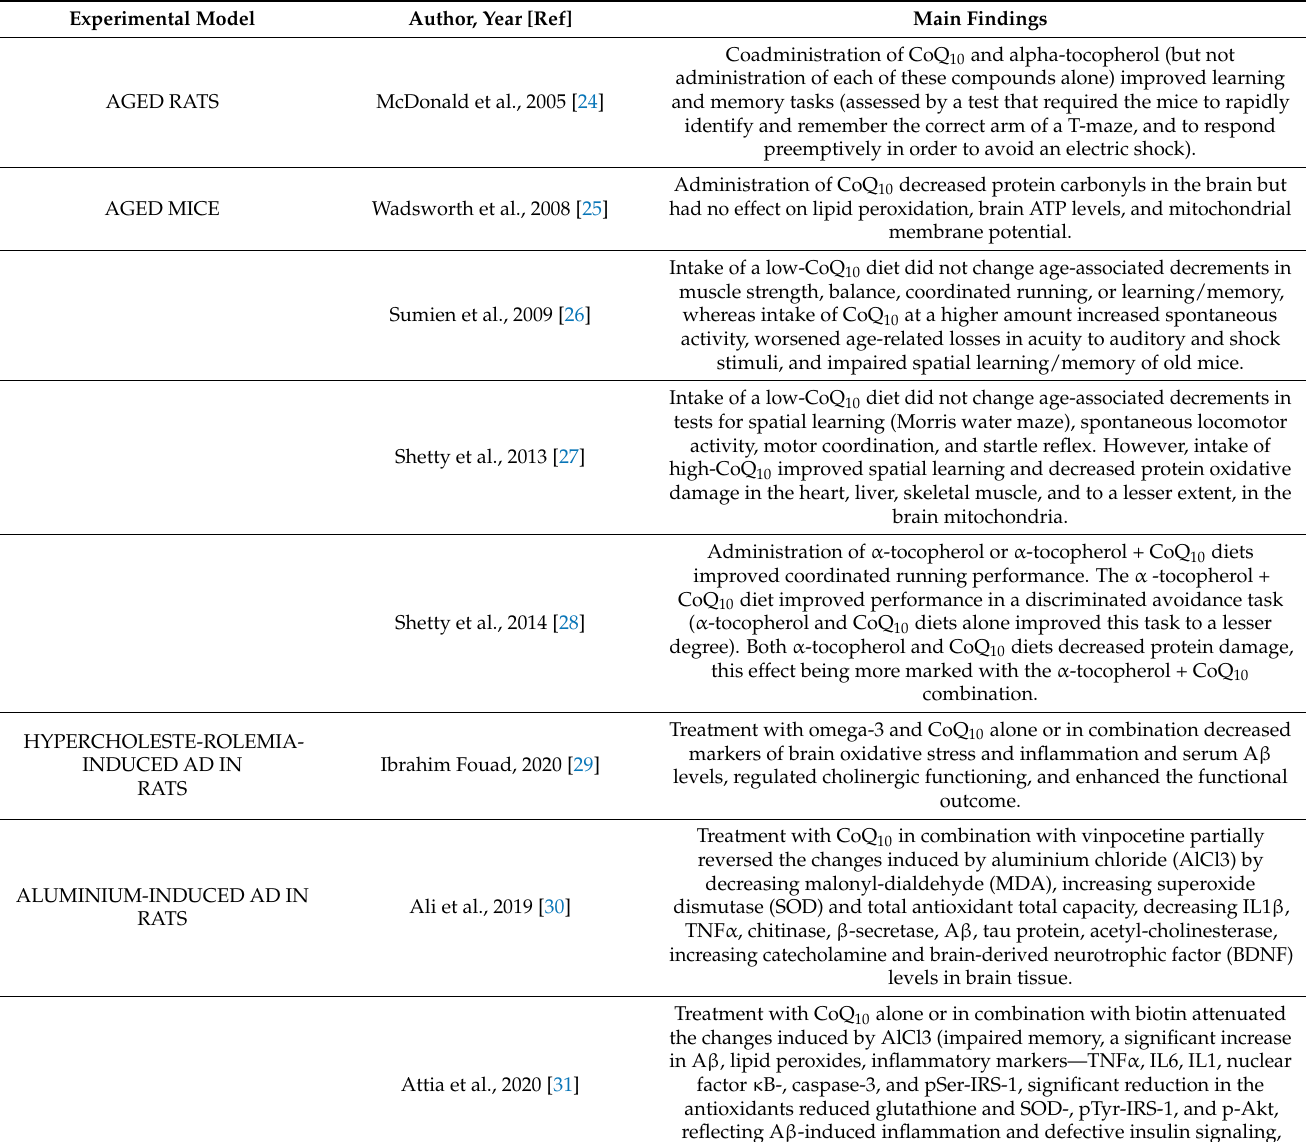
Table 2. Studies on the effects of coenzyme Q 10 in different experimental models of Alzheimer’s